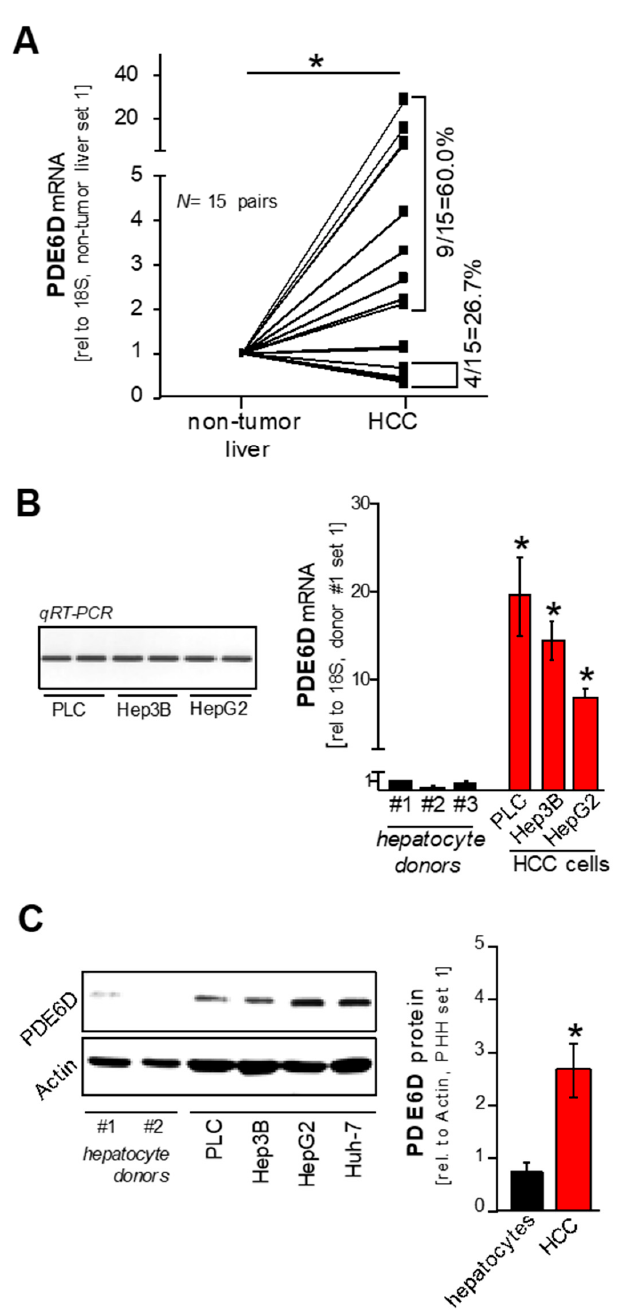
Figure 2. PDE6D expression in HCC in vivo and in vitro. ( A ) PDE6D mRNA levels as quantified by qRT-PCR analysis of HCC patient samples and paired non-tumorous liver tissues (* p < 0.05). ( B ) Detection of PDE6D mRNA in human HCC cells (PLC, Hep3B, HepG2) after qRT-PCR amplification using gel electrophoresis (left panel) and relative PDE6D mRNA levels (qRT-PCR) in human HCC cell lines (PLC, Hep3B, HepG2) compared with primary human hepatocytes derived from different donors (#1–3) (right panel) (* p < 0.05 vs. hepatocytes). ( C ) Exemplary Western blot image (left panel) and summarized densitometric quantification (right panel) of PDE6D protein levels in HCC cells (PLC, Hep3B, HepG2, Huh-7) compared with hepatocytes derived from different donors (#1–2) (* p < 0.05 vs. hepatocytes).